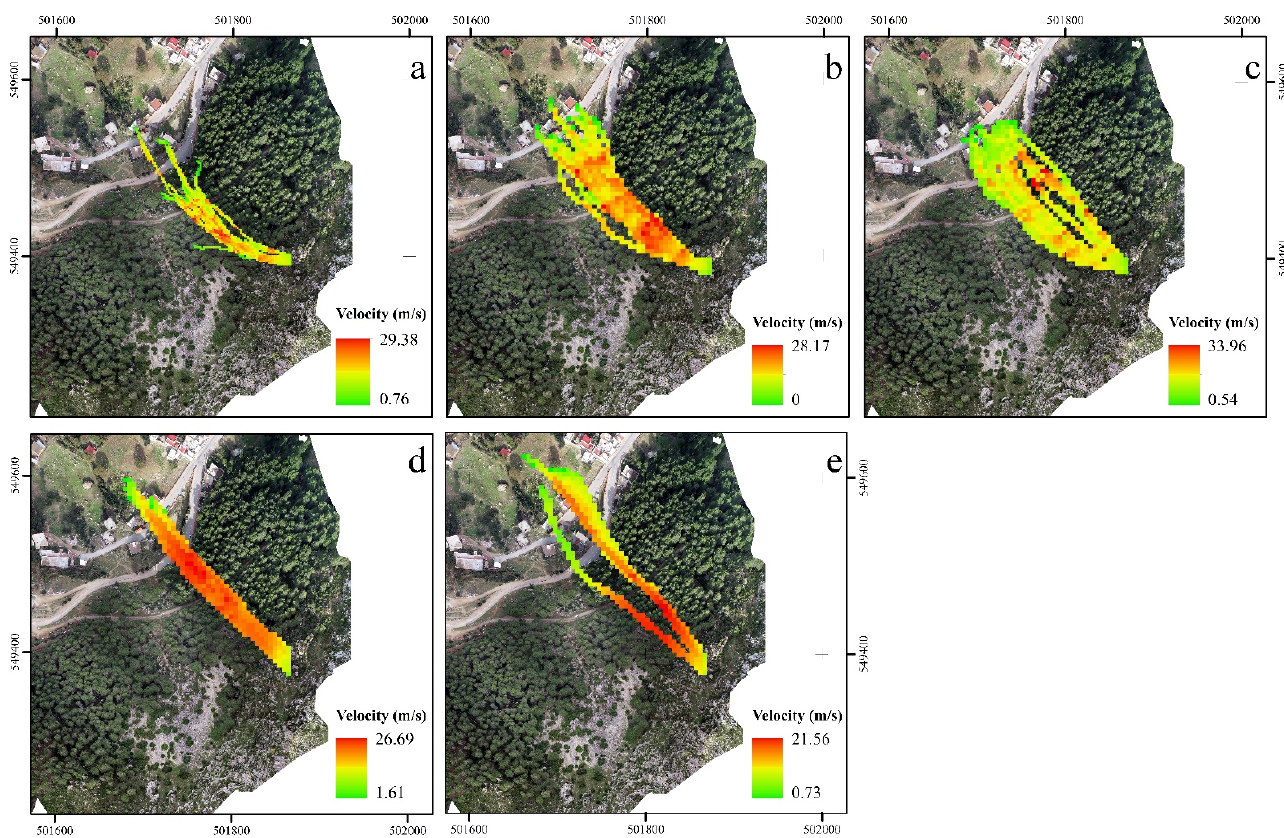
Figure 10. Simulated rockfall velocity simulation in the Bouanane cliff obtained using the 1 m DEM ( a ), the 2 m DEM ( b ), the 3 m DEM ( c ), the 5 m DEM ( d ) and the 30 m DEM ( e ).